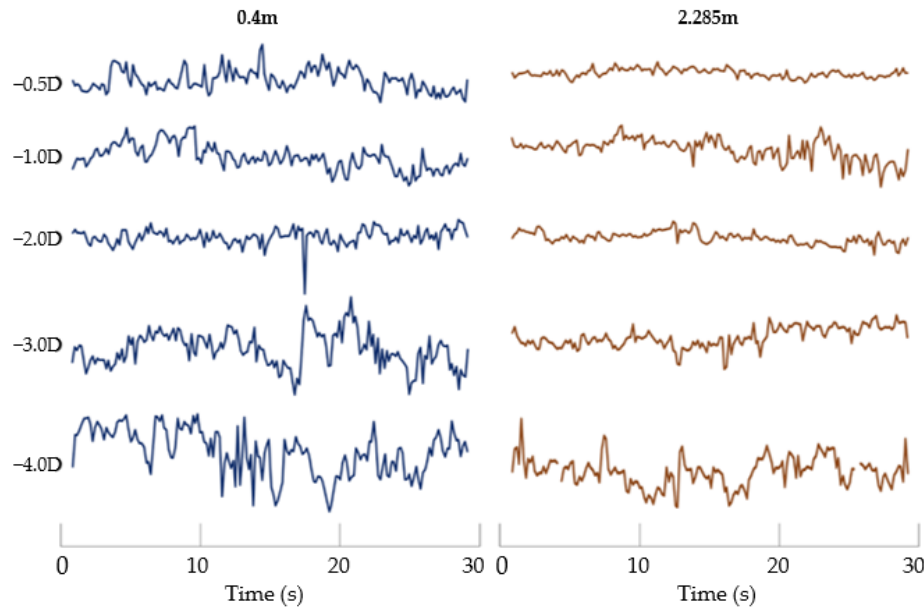
Figure 6. The fluctuations of the accommodation response for 5 subjects gazing at a real object at 0.4 m and gazing at a virtual image at 2.285 m for 30 s. The corresponding refractive corrections are − 0.5, − 1, − 2, − 3, and − 4 D, respectively. − 0.5, − 1, − 2, − 3, and − 4 D,